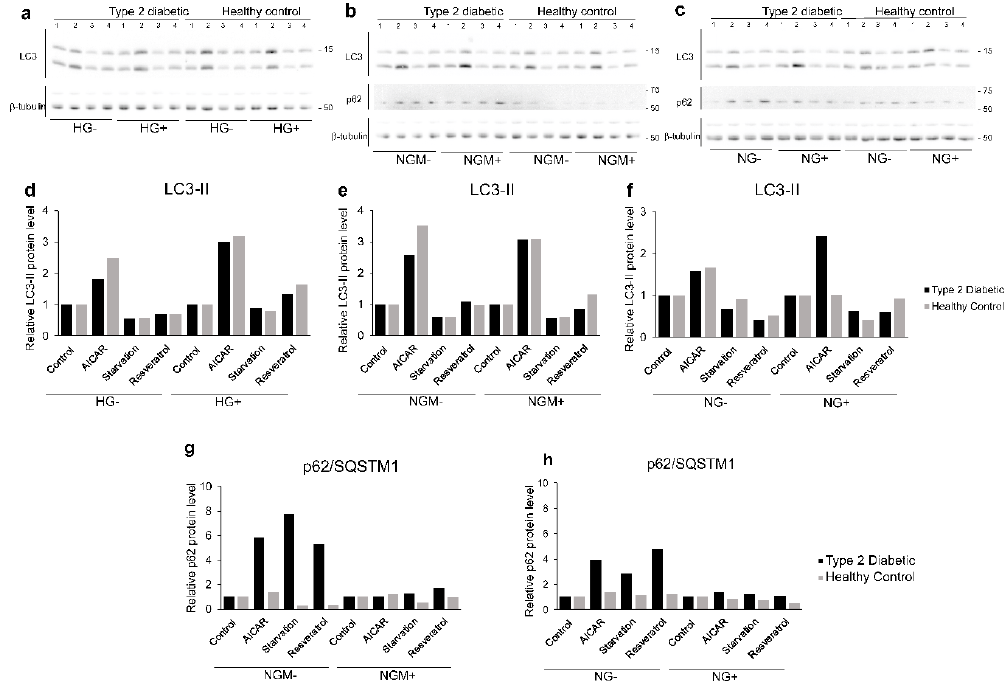
Figure 8. Activation of autophagy was analyzed using hiPSC-RPE cells derived from type 2 diabetic (UTA.08203.DMs) or healthy control (UTA.10902.EURCCs) patients cultured in high glucose (HG, 25 mM, ( a , d )), normal glucose (5 mM) balanced with mannitol (19.5 mM) (NGM, b , e , g ), or normal glucose (NG, 5 mM, ( c , f , h )) for five weeks. Thereafter, cultures were subjected to 5-aminoimidazole-4-carboxyamide ribonucleoside (AICAR, 2 mM), starvation (no serum), or resveratrol (20 mM) for 24 h, and whole proteins were extracted and analyzed using Western blots labelled with LC3, p62/SQSTM1, and α -tubulin. The Western blots are represented in ( a – c ). The line on the left denotes the size of the blot. The α -tubulin band was used as a loading control. The values are correlated to the untreated sample, which is marked as 1. AICAR increased the relative LC3-II level in both diabetic and healthy control hiPSC-RPEs and in